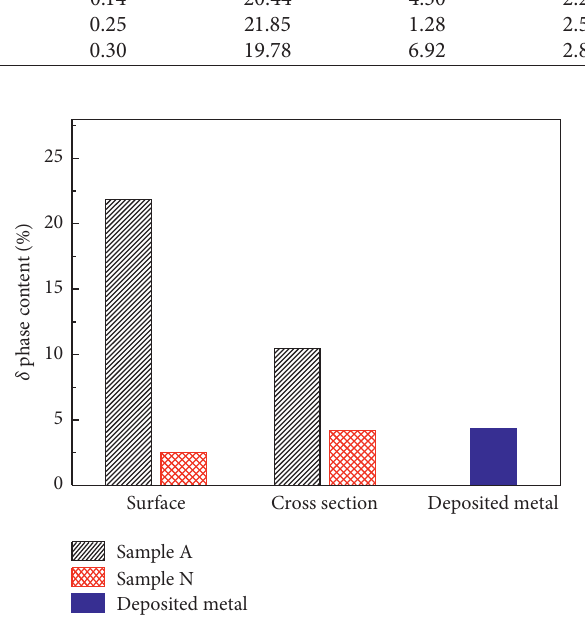
Figure 5: The δ content at room